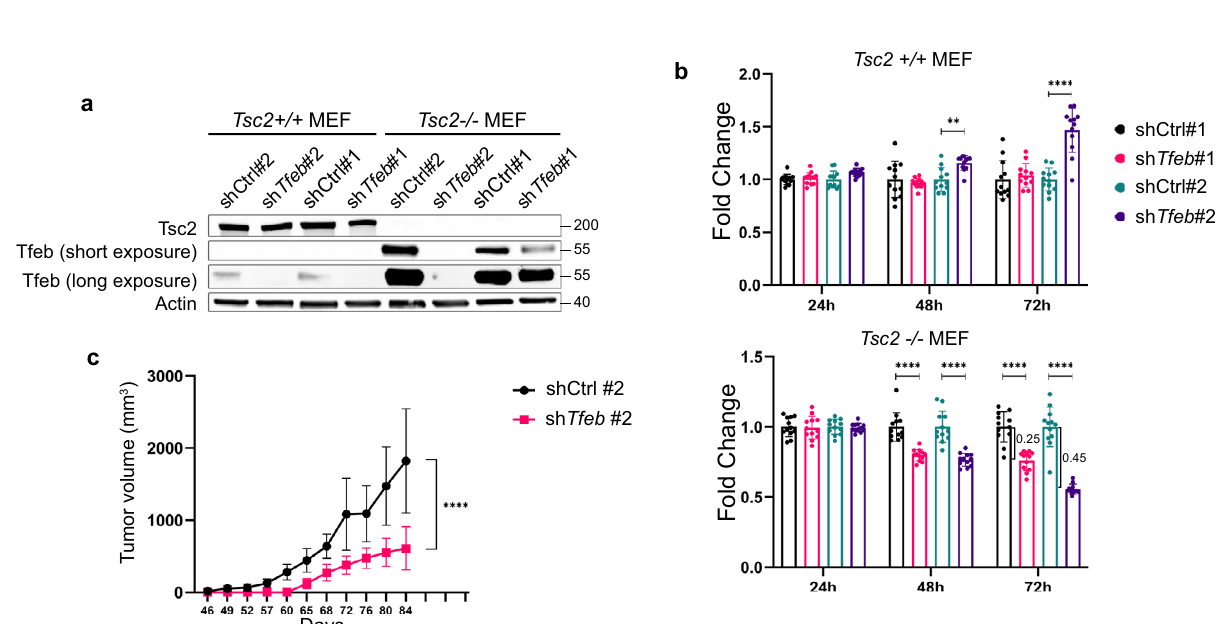
Fig. 4 Tfeb downregulation decreases proliferation of Tsc -de fi cient cells. a Con fi rmation of shRNA knockdown of TFEB in Tsc2 + / + and Tsc2 − / − MEFs ( n = 3 biological replicates per condition). b Proliferation of Tsc2 + / + and Tsc2 − / − MEFs with Ctrl or Tfeb shRNA assessed by crystal violet staining ( n = 12 biological replicates per condition). c Tumor volume of Tsc2 − / − MEFs with Ctrl or Tfeb shRNA#2 subcutaneously injected into immunode fi cient mice ( n = 10 each group). Graphs are presented as mean ± SD. Statistical analyses were performed using two-tailed Students t -test, ** p < 0.01, **** p < 0.0001. Source data are provided as a Source data fi